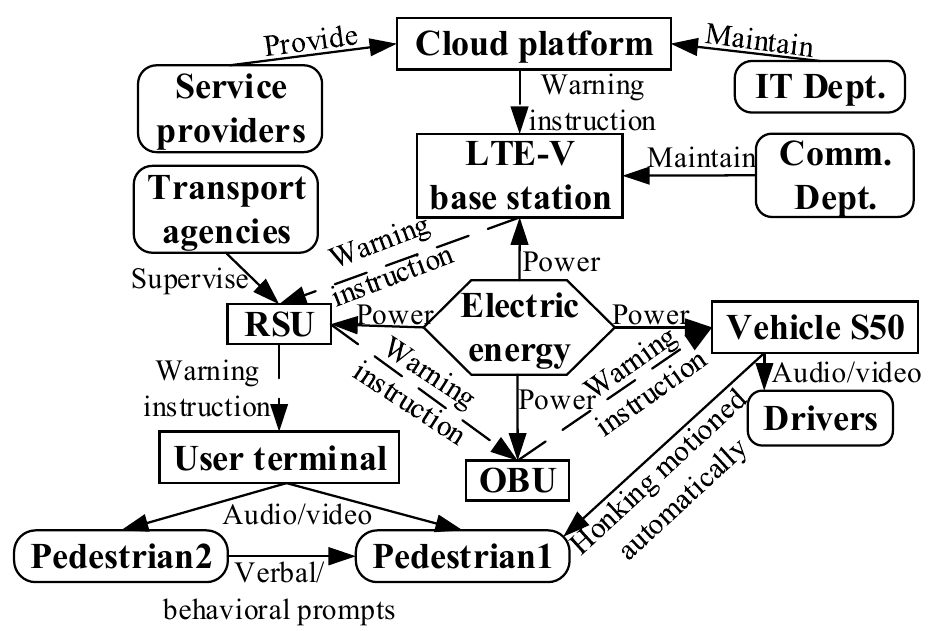
Figure 15. Function model of vehicle–pedestrian collision-warning service system. Step 4: Cloud platform supports data transmission, storage, management, and analysis.